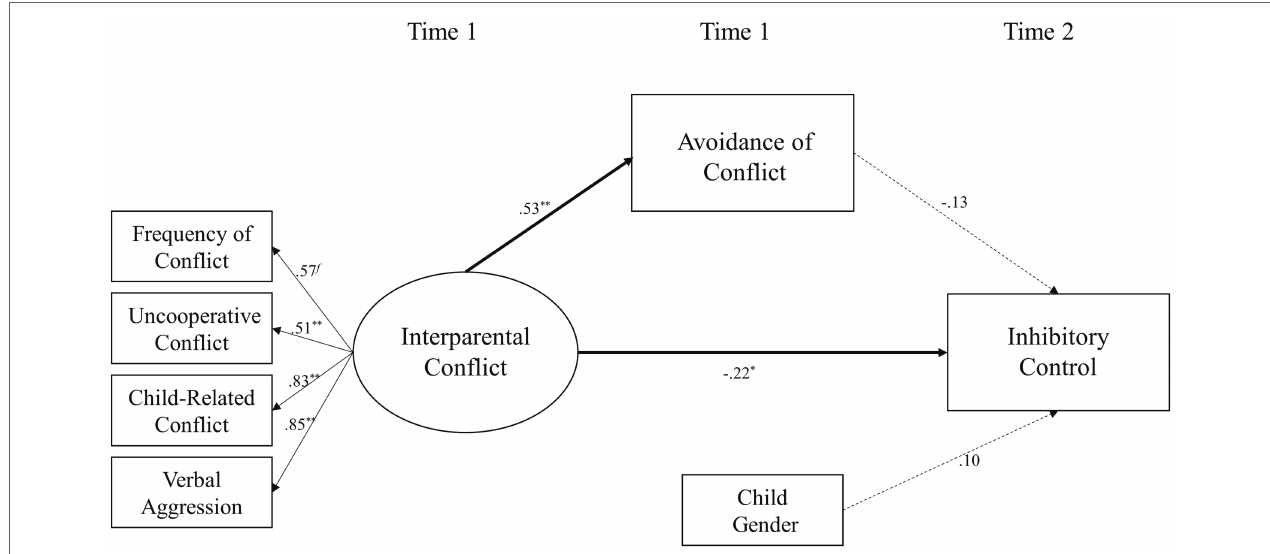
FIGURE 4 | A structural equation model examining avoidance of children as a mediator linking destructive interparental conflict to inhibitory control of children. ∗ p < 0.05 and ∗∗ p <